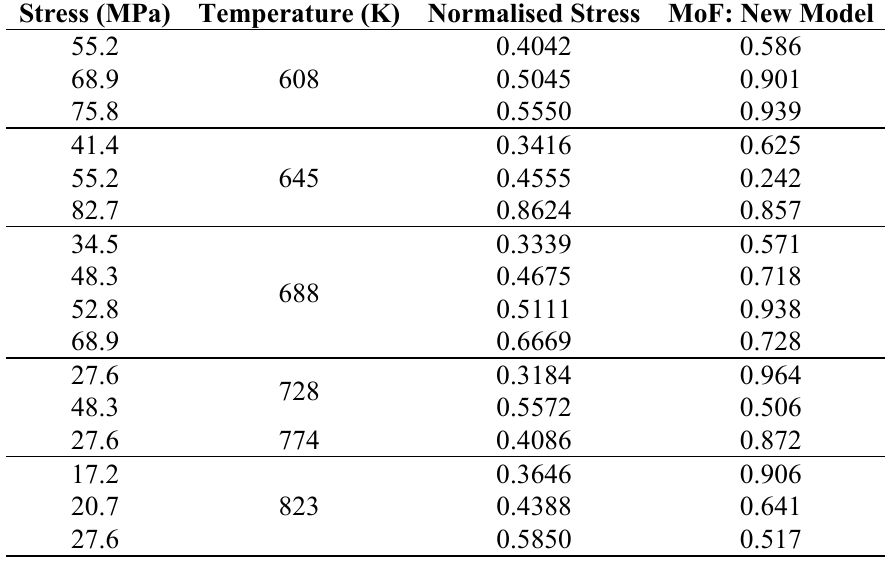
Stress (MPa) Temperature (K) Normalised